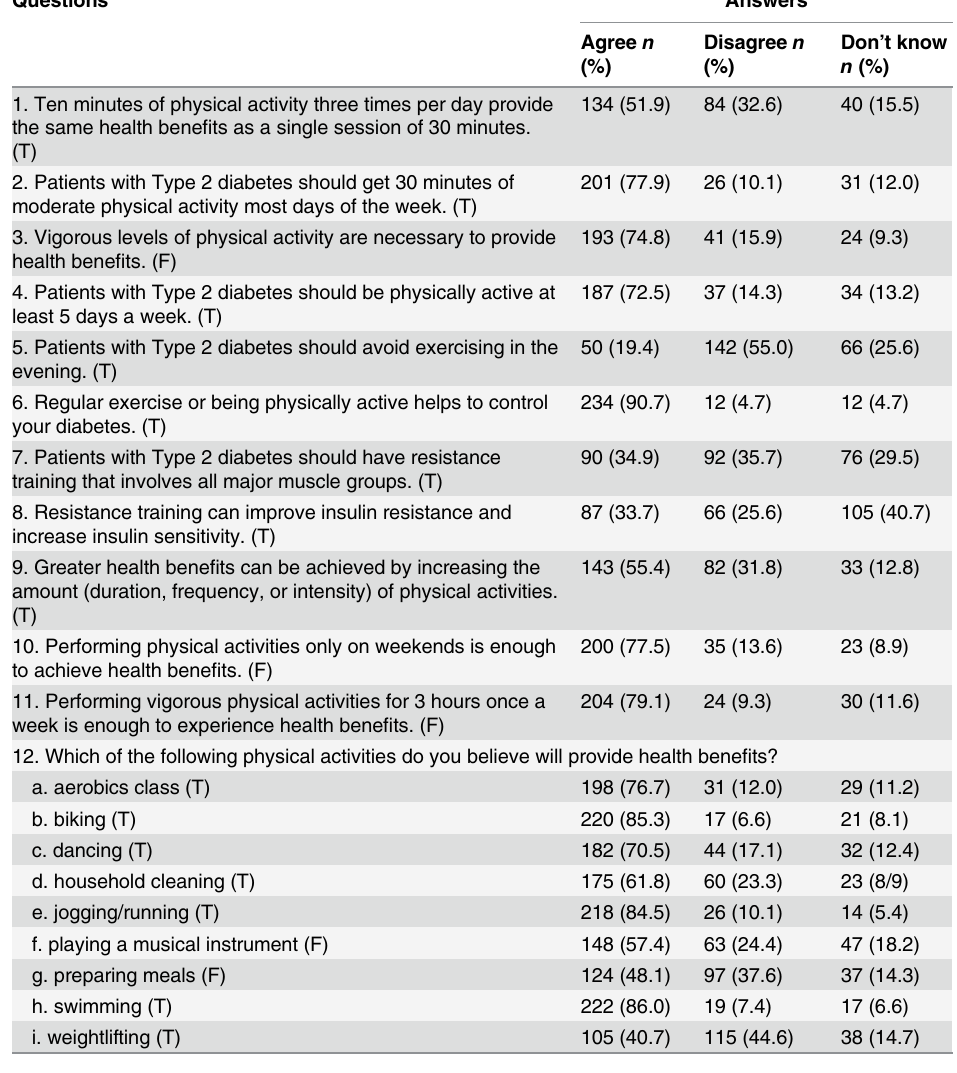
Table 2. Proportions of different answers in each physical activity knowledge